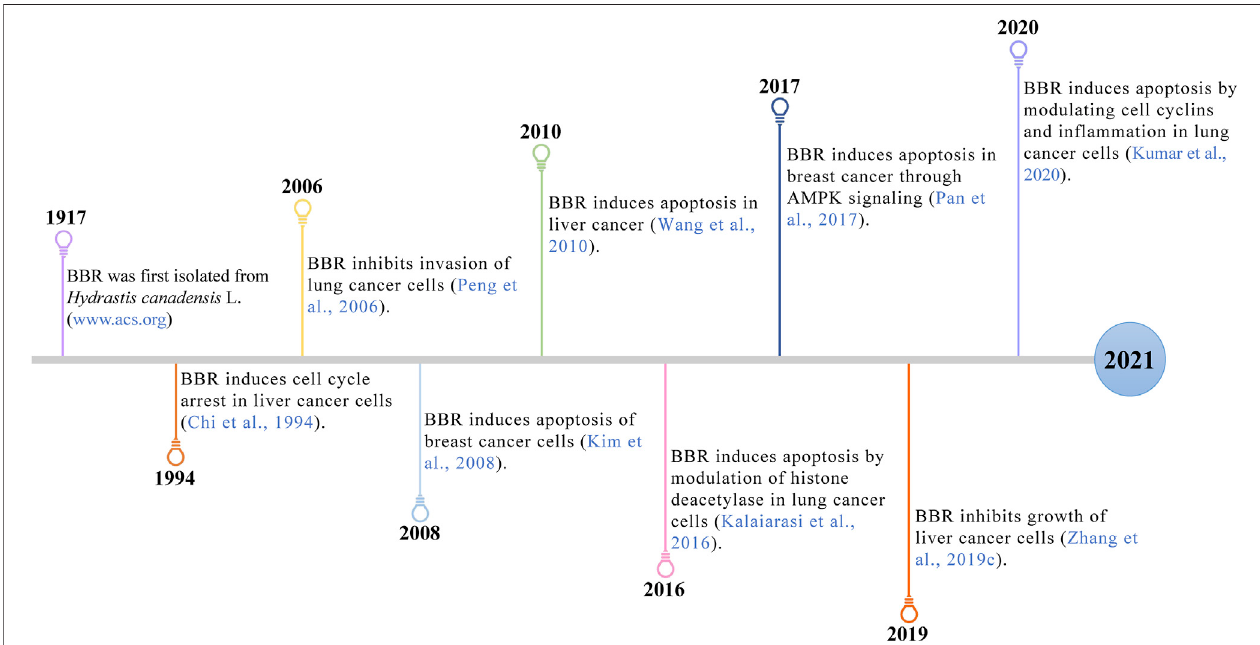
FIGURE 1 | Timeline: Continuous evidences of BBR anticancer effects on three cancers.